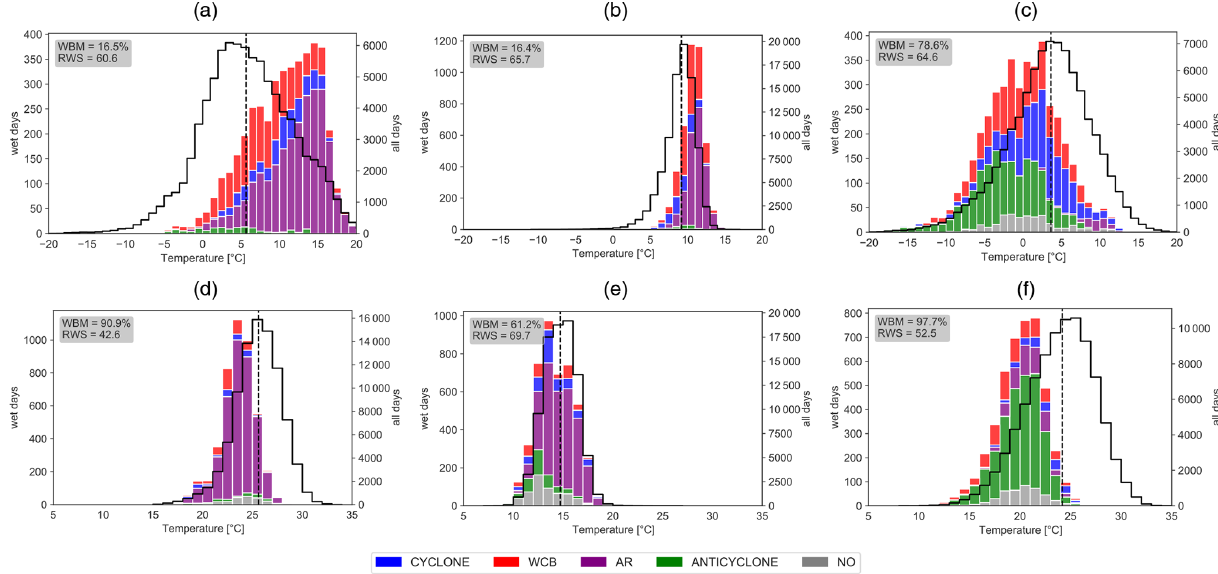
Figure 4. Same as Fig. 3 but for three regions in North America: E-US (a, d) , W-US (b, e) , and C-US (c, f)